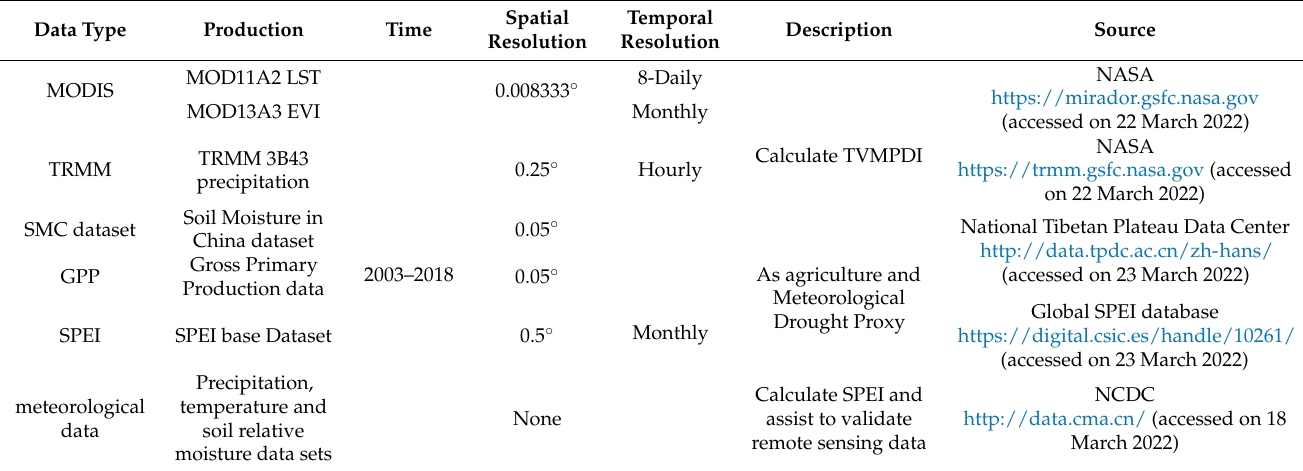
Table 1. The datasets used in the